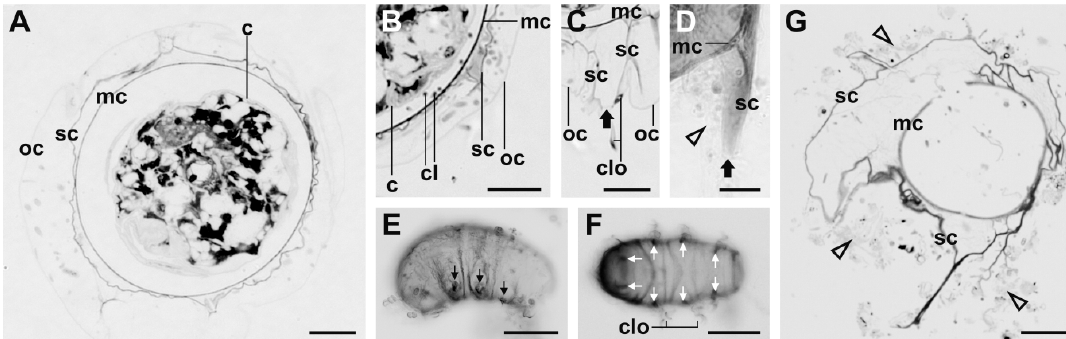
Figure 4. Cuticular capsule of the cyst, BF. ( A–C ) Cross-section through the cyst; ( D–G ) empty cuticular capsules; ( C–F ) legs of the sarcophagus cuticle; ( C ) cross-section through the leg of the sarcophagus cuticle; ( D ) fourth leg of the sarcophagus cuticle; ( E ) legs of the sarcophagus cuticle, lateral view; ( F ) legs of the sarcophagus cuticle, ventral view; ( G ) cross-section through the empty cuticular capsule. Scale bars 10 µ m in A,B,C,D,G and 50 µ m in E,F. Cuticle of the animal (c); claws of the animal (cl); claws of the old cuticle (clo); mummy cuticle (mc); old cuticle (oc); sarcophagus cuticle (sc); remains of the old cuticle (empty arrowhead); small hole at the end of the sarcophagus cuticle’s leg (thick filled arrow); legs of the sarcophagus cuticle (thin arrow).